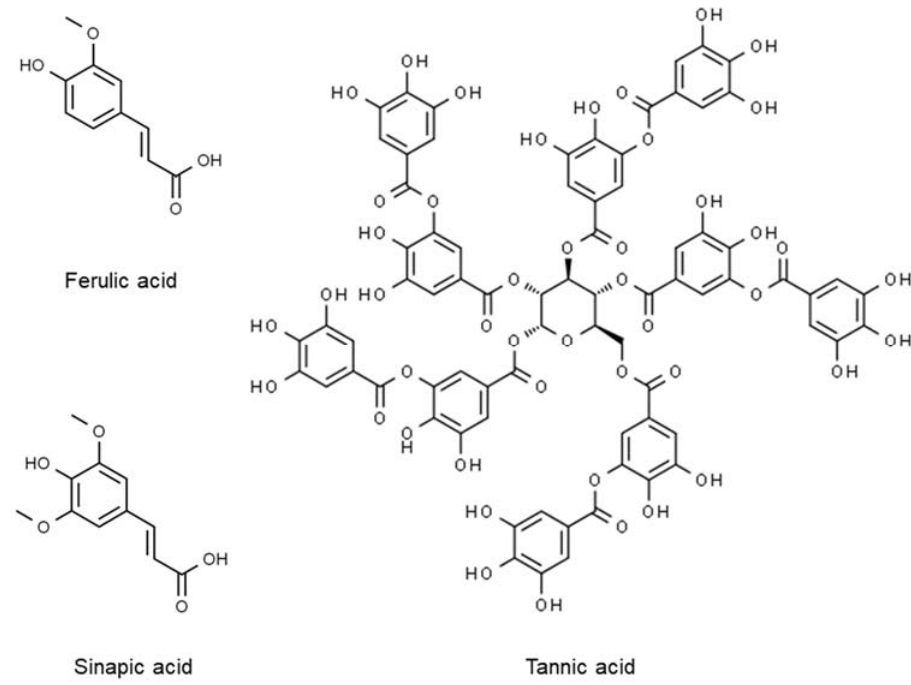
Figure 6. Polyphenolic compounds in kenaf seed.